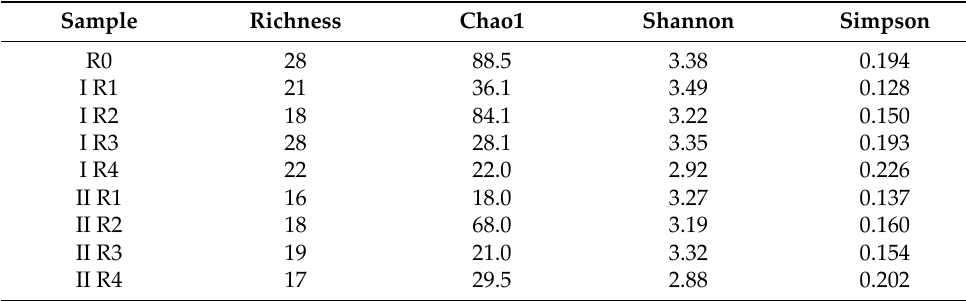
Table 2. Microbial diversity indices of different